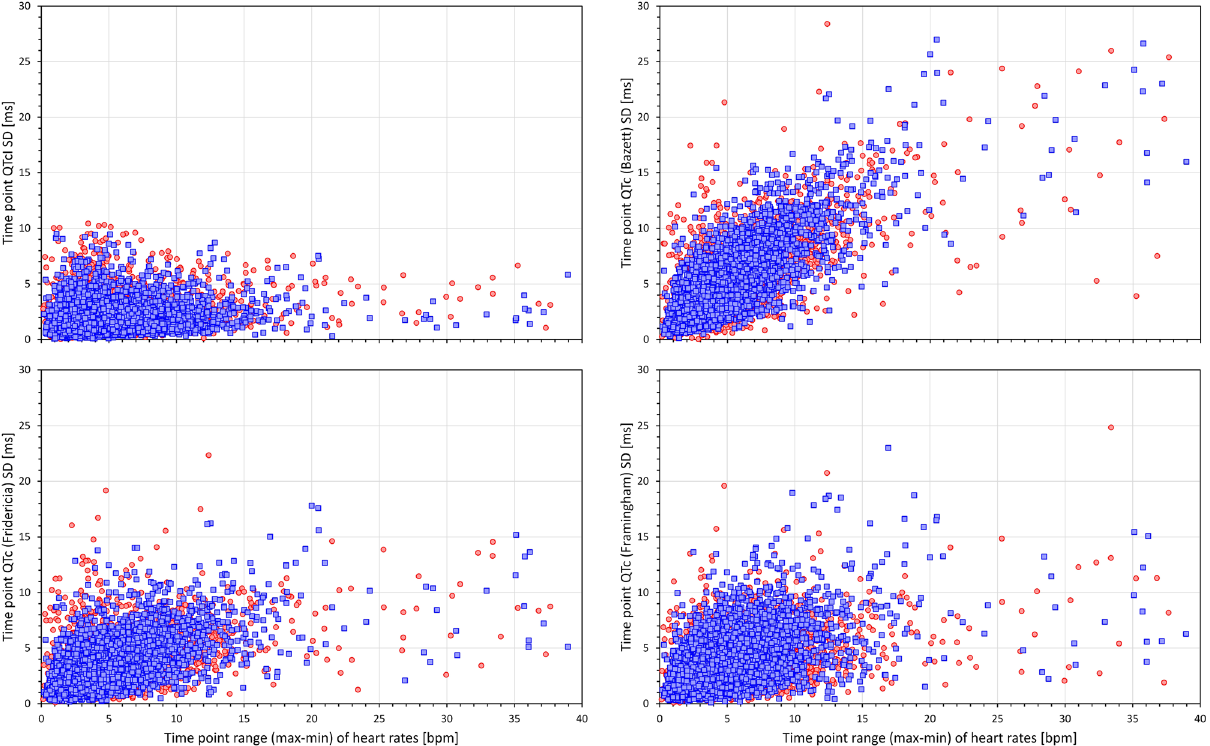
Figure 6. Scatter diagrams between heart rate ranges (maximum–minmum) and standard deviations of QTc values of individual study time-points. The left top panel shows the relationship for QTcI intervals, the top right, bottom left, and bottom right panels show the relationship for Bazett, Fridericia, and Framingham corrected QTc intervals, respectively. In all panels, all time-points of all study subjects are pooled together, red and blue marks show the data of female and male subjects, respectively. Outliers beyond the ranges of the axes were also present in the data. Note that pooling all time-points of all subjects together is not suitable for statistical analysis but serves visual interpretation—the stronger the relationship between the variability of the underlying heart rate and the variability of the QTc intervals within the same time-point, the greater the failure of the correction formula in eliminating the effects of heart rate on QTc values. Compare the panels with panels of Fig. 7. bpm beats per minute, max maximum, min minimum, SD standard